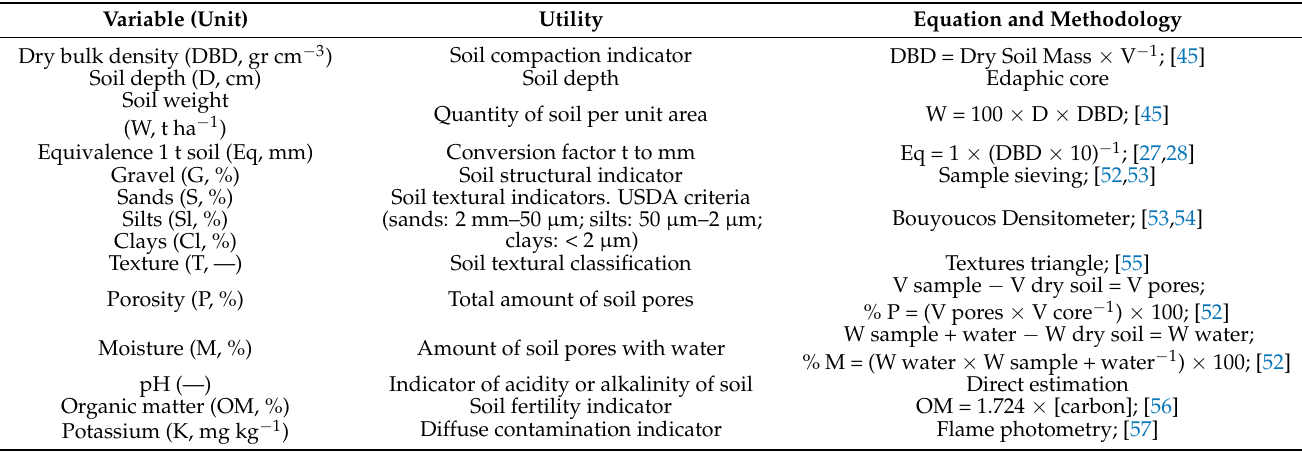
Table 2. Edaphic variables analysed indicating their abbreviation and unit, utility, and the procedure followed to calculate each of them, including references (Equation and Methodology), whereby W: weight (gr); V: volume (cm 3